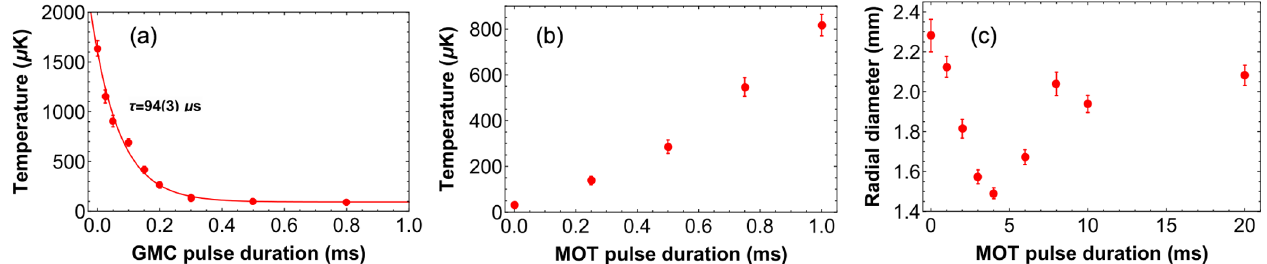
FIG. 5. Compression of the molecular cloud by combining the GMC with the dual-frequency dc MOT at a B gradient of 47 G = cm. (a) Temperature versus the duration of the GMC pulse, with I ¼ 30 I 0 , Δ ¼ 3 . 1 Γ , and δ ¼ 0 . The solid line is an exponential fit. (b),(c) Temperature and in situ diameter of the molecular cloud versus the duration of a single MOT pulse, which is applied after the 2 ms GMC